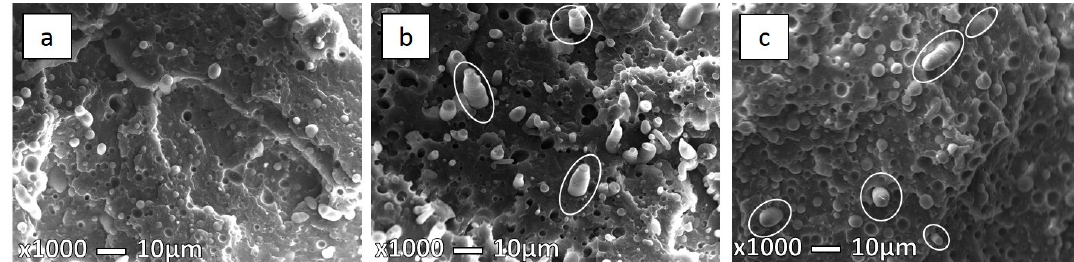
Figure 6. SEM micrographs of freeze-fracture surface under liquid nitrogen 70PP/30PET IMB at ( a ) 210 ◦ C; ( b ) 230 ◦ C; and ( c ) 280 ◦ C.